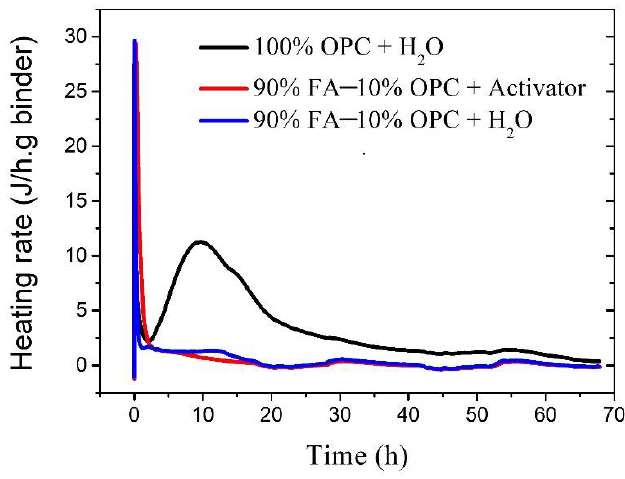
Crystals 2020 , 10 , x FOR PEER REVIEW Figure 5. Evolution of the heat of reaction of the pastes. Figure 5. Evolution of the heat of reaction of the pastes.